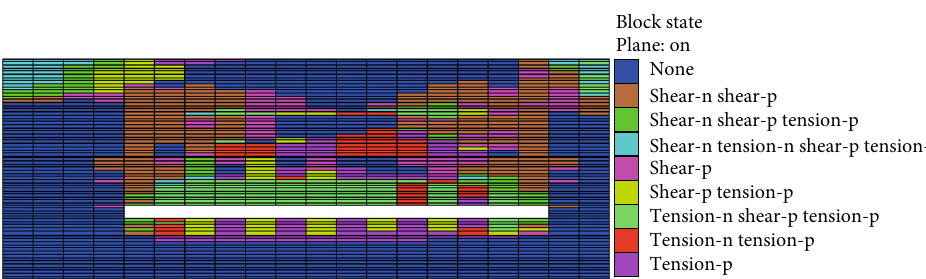
Figure 6: Model unit failure state when mining 140m.